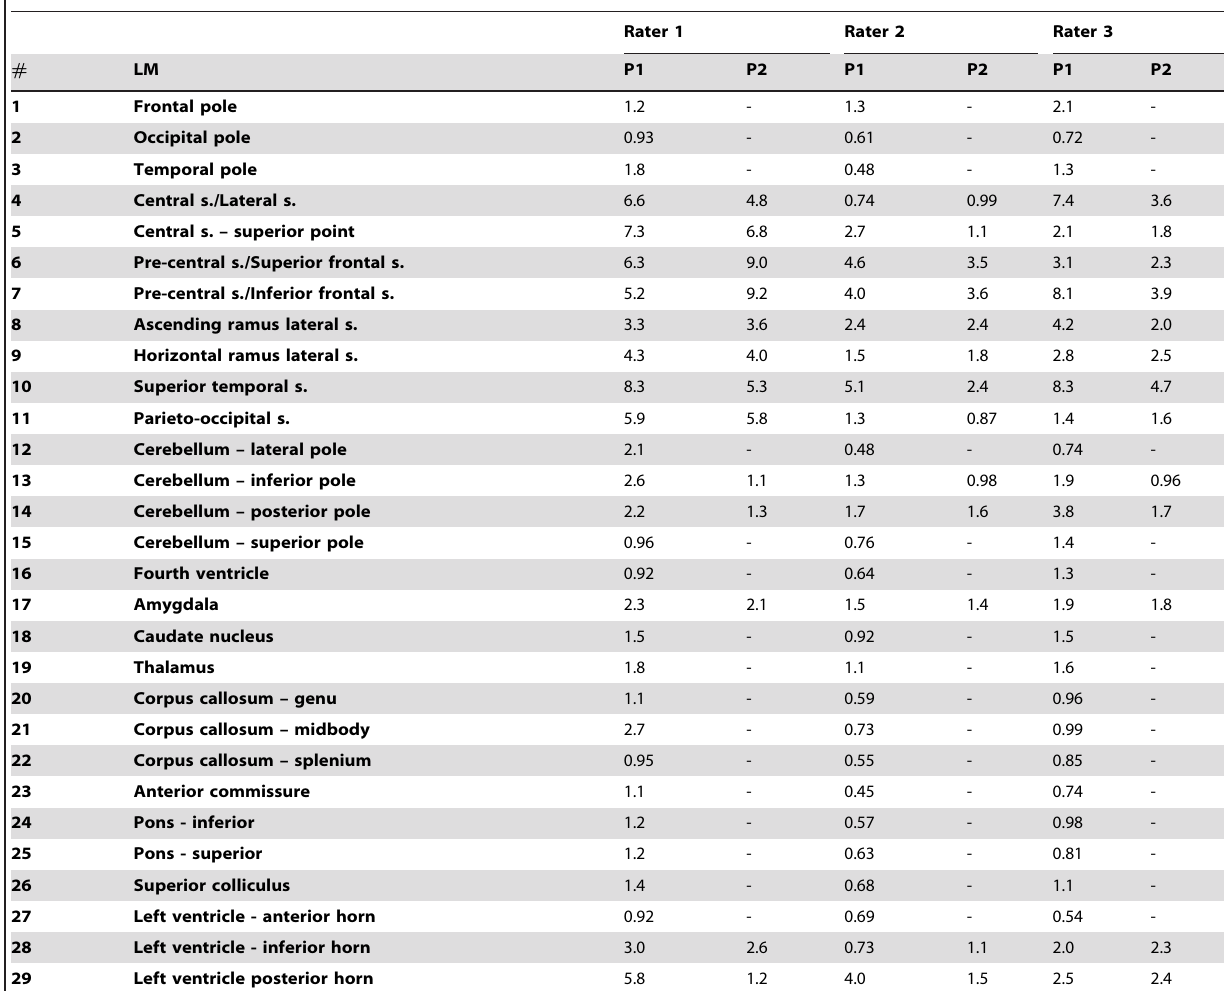
Table 3. Average intra-observer error by